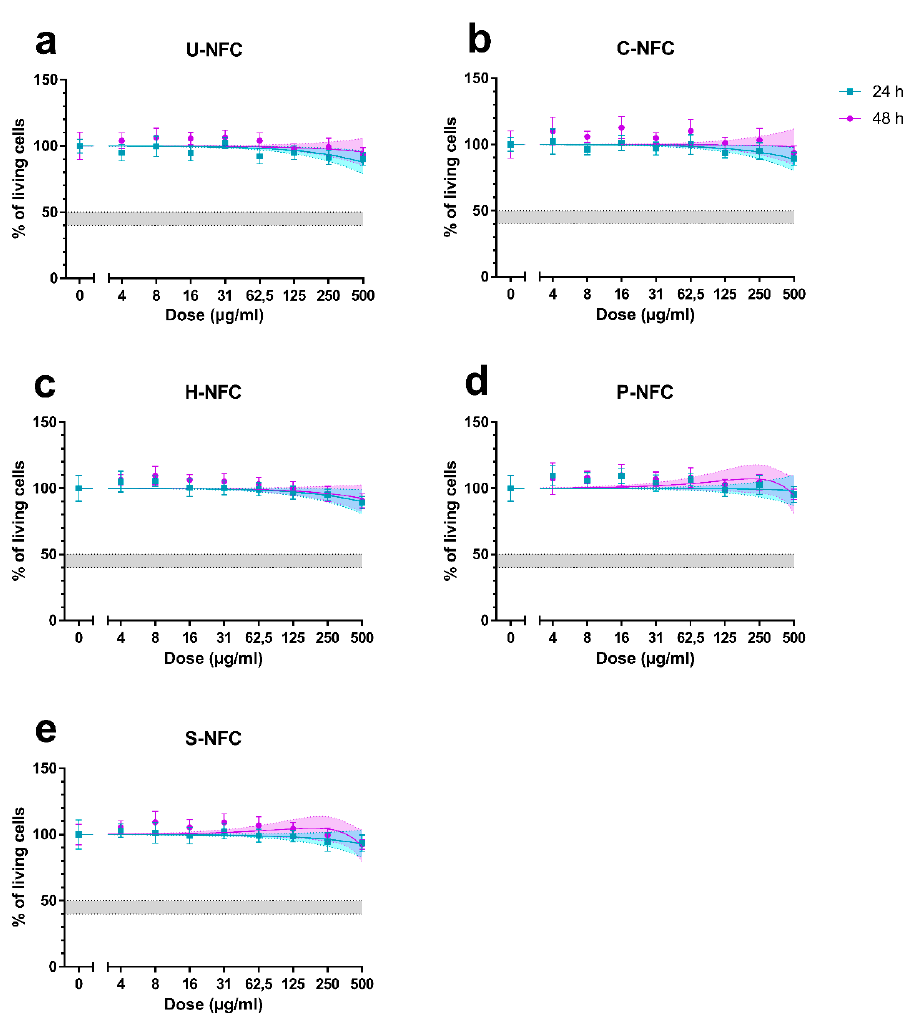
Figure 4. Cytotoxicity of the nanofibrillated cellulose (NFC) materials. The total number of living cells was counted at 24 and 48 h exposure to ( a ) U-NFC, ( b ) C-NFC, ( c ) H-NFC, ( d ) P-NFC and ( e ) S-NFC, and the results were normalized with the unexposed control. Results are presented as the mean ± standard error of the mean. Graphs are plotted with 95% confidence interval (colored areas). The range of 45 ± 5% living cells (corresponding to the 55 ± 5% cytotoxicity) is indicated by the grey area in each graph.